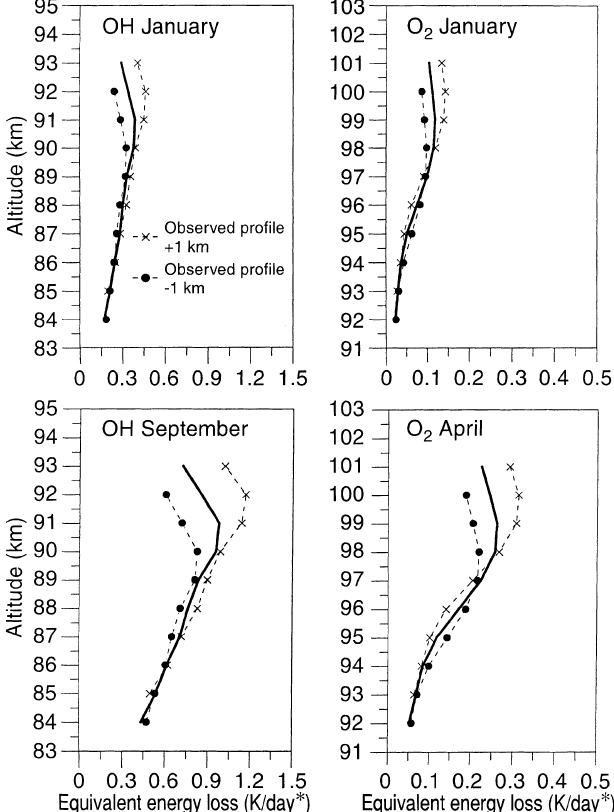
Fig. 5. Equivalent energy loss rates (in K/day (cid:3) ) due to the OH Meinel and O (cid:3) bands as a function of altitude for the observed profile and 2 when this observed profile is shifted up and down by